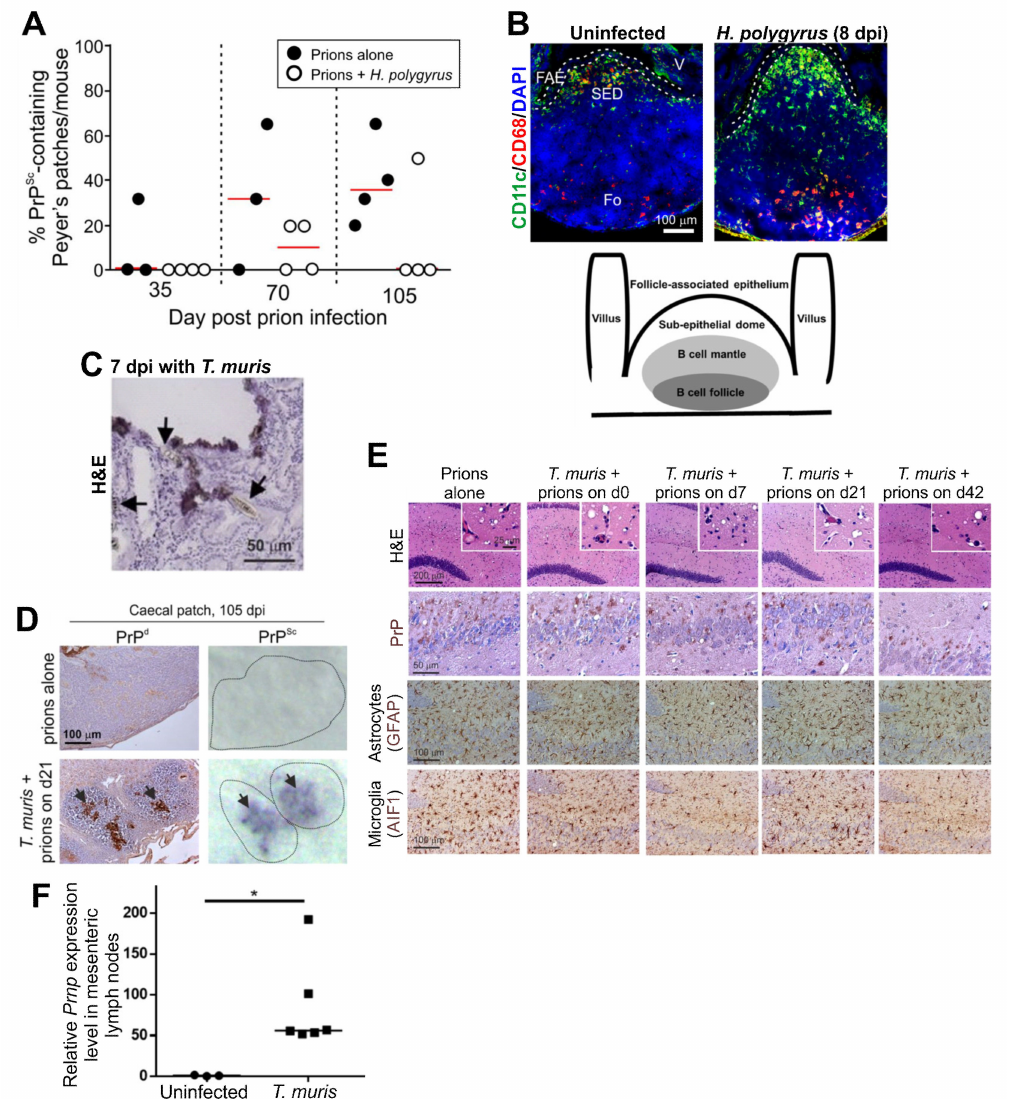
Figure 4. E ff ect of co-infections with gastrointestinal helminths on oral prion disease pathogenesis in.mice. Panels A and B illustrate the e ff ects of co-infection with Heligmosomoides polygyrus in the small intestine [134]. C57BL / 6J mice were first orally-infected with H. polygyrus . L3 larvae and orally infected with ME7 scrapie prions 8 days later. ( A ) The frequency of PrP Sc -containing Peyer’s patches was lower in mice co-infected with H. polygyrus . ( B ) Immunofluorescent analysis showed that the distribution of CD11c + mononuclear phagocytes (green) was disturbed in the Peyer’s patches on d 8 after H. polygyrus infection. FAE, follicle-associated epithelium; SED, subepithelial dome; Fo, follicle; V, villus; dpi, days post-infection. Cartoon shows the anatomical boundaries in the Peyer’s patch. Panels C-E illustrate the e ff ects of co-infection with Trichuris muris in the large intestine [134]. C57BL / 6J mice were first orally-infected T. muris infective eggs and orally infected with ME7 scrapie prions and the days indicated after the helminth infection. ( C ) Arrows show the close association of T. muris with the caecal epithelium and lamina propria and the damage caused to the epithelium. ( D ) In mice infected with prions alone PrPSc was undetectable in the caecal patches at 105 dpi. However, high levels of PrP Sc were detected in the caecal patches of the mice co-infected with T. muris . ( E ) High levels of prion-specific vacuolation (H&E), PrP accumulation, reactive astrocytes (GFAP + cells, brown) and active microglia (AIF1 + cells, brown) were detected in the brains of mice from each infection group. Counterstain, haematoxylin, blue. ( F ) Upregulated Prnp expression in the mesenteric lymph nodes of T. muris -infected mice. *, p < 0.05. Panels A and B are adapted from [134] under the terms of the Creative Commons Attribution Licence (CC-BY-4.0; https: // creativecommons.org / licenses / by / 4.0 / ). Panels C–E are adapted from [40] under the terms of the Creative Commons Unported Licence (CC-BY-3.0; https: // creativecommons.org / licenses / by / 3.0 /